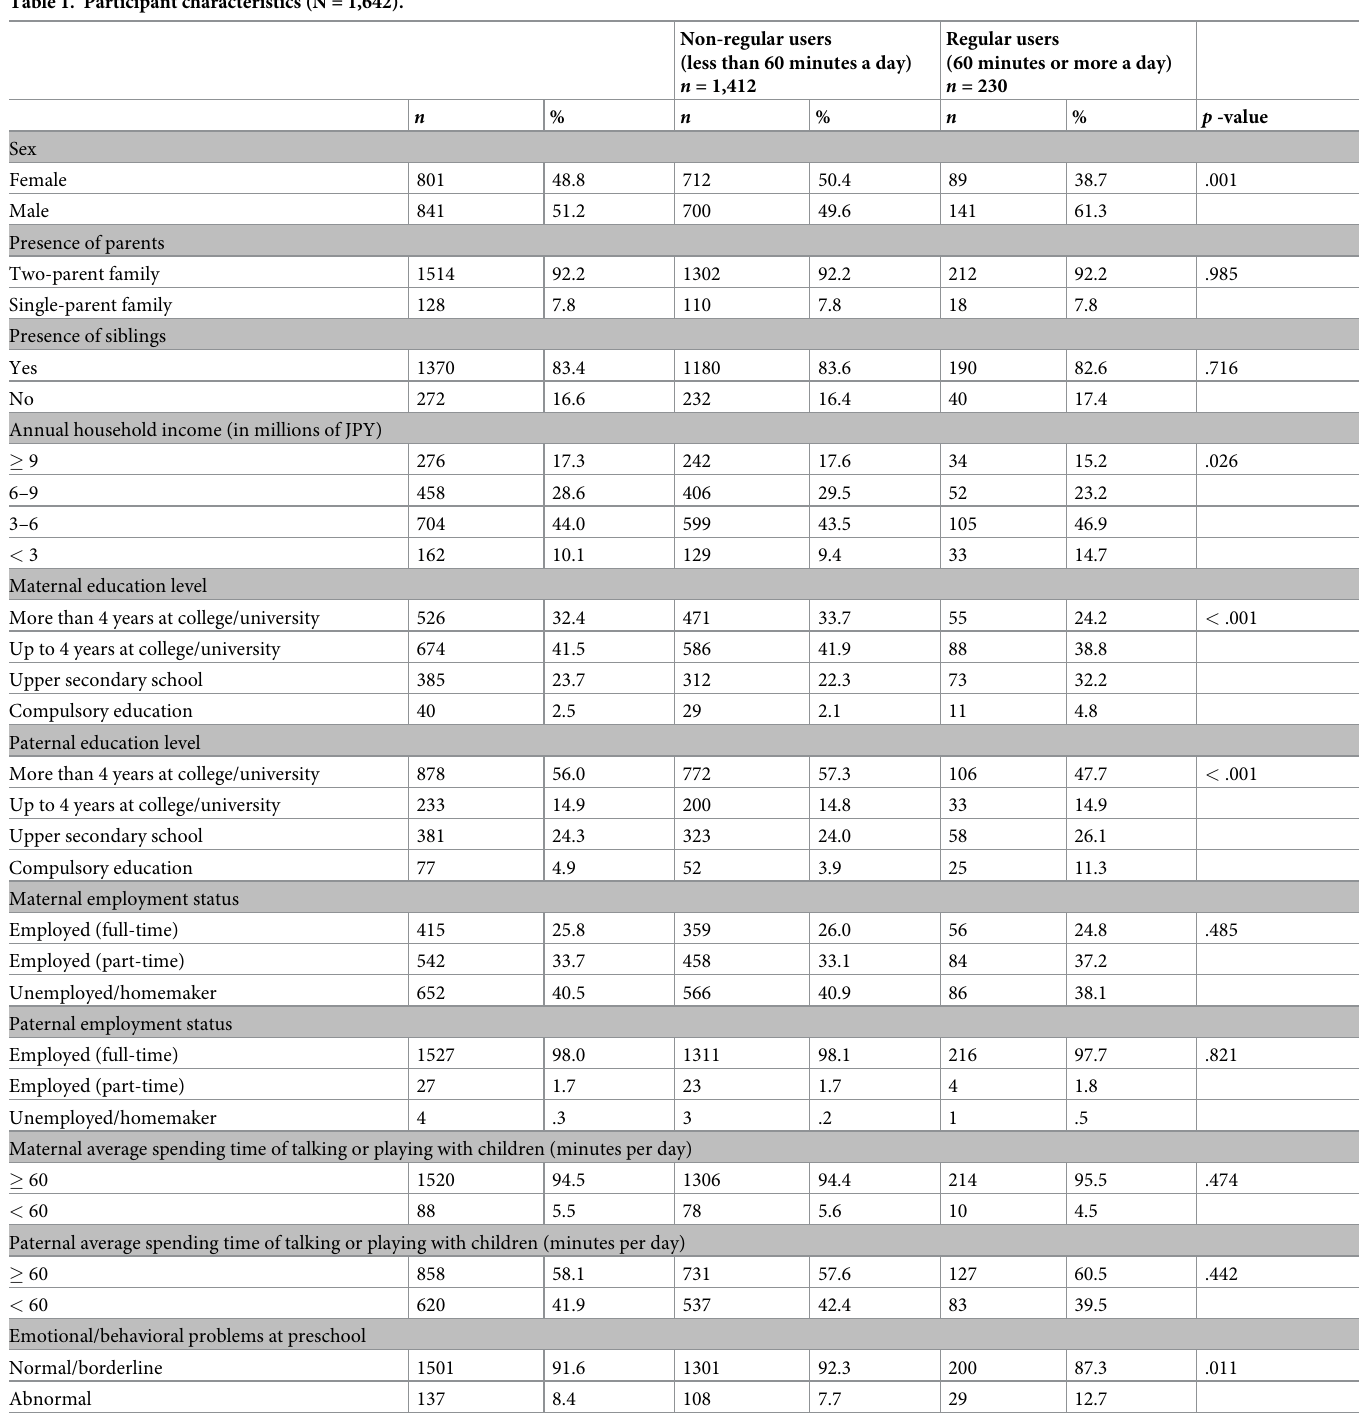
Table 1. Participant characteristics (N =